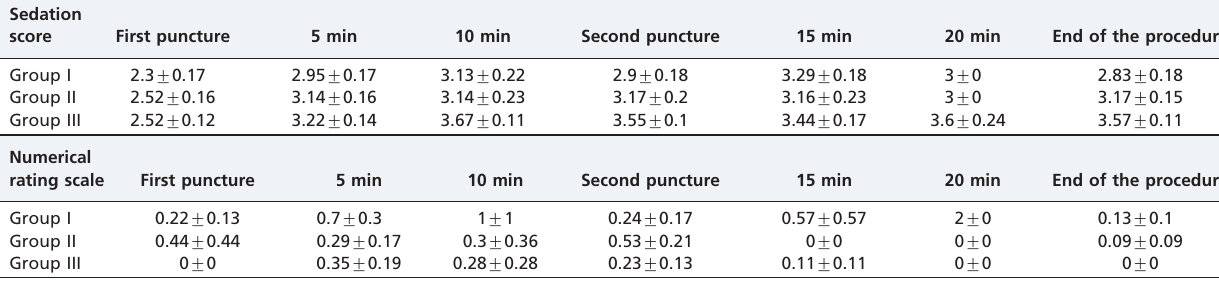
Table 3 - Sedation scores and numerical rating